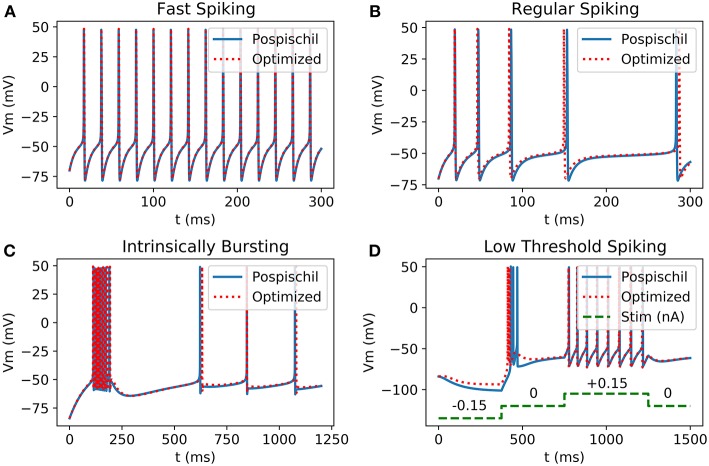
Comparison between Matlab implementation of HH neurons using Pospischil parameters and Matlab implementation of simplified model: (A) Fast Spiking neuron possesses a constant frequency while the current stimulation is constant; (B) Regular Spiking neuron shows a frequency adaptation; (C) Intrinsically bursting neuron begins with a burst when the threshold is exceeded; (D) Low Threshold Spiking burst after when a negative excitation ends and has a regular behavior when excited with positive current, the burst of the optimized result shows less spikes than the original version.